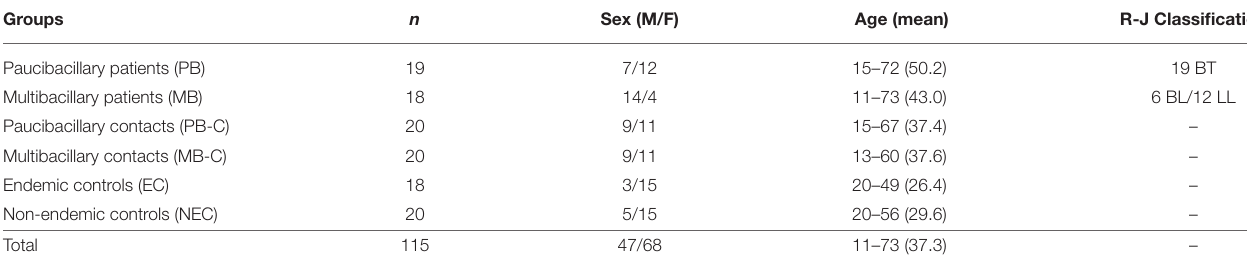
TABLE 1 | Characteristics of the study